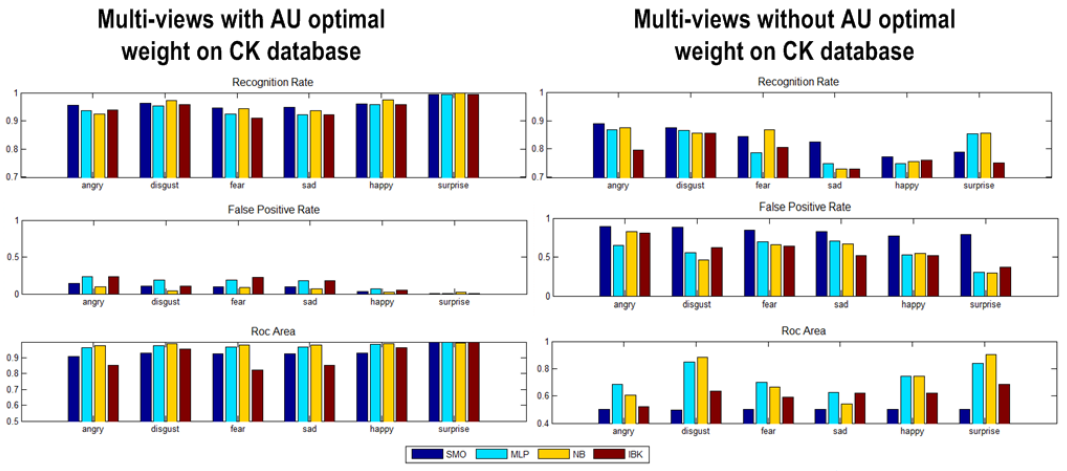
Figure 10. The results of the multi-layer AU fusion strategy on the CK dataset.